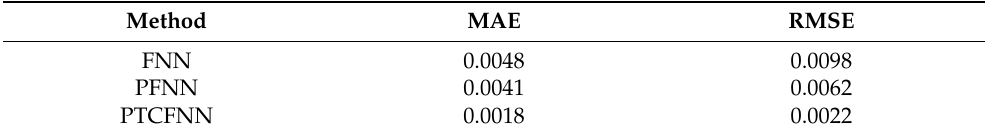
Table 2. MAE and